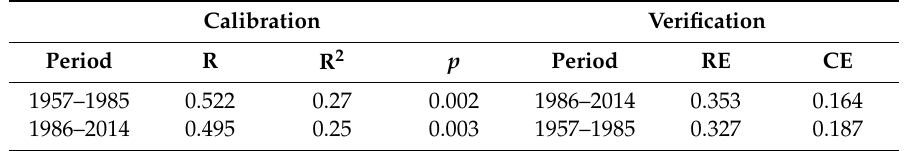
Figure 7. Comparisons of ( a ) observed (solid line) and reconstructed (dash line) pMay-cApr scPDSI during the common period 1957–2014, and ( b ) their first-di ff erenced data during 1958–2014. Table 2. Statistics of split calibration verification test results for the common period 1957–2014 CE.